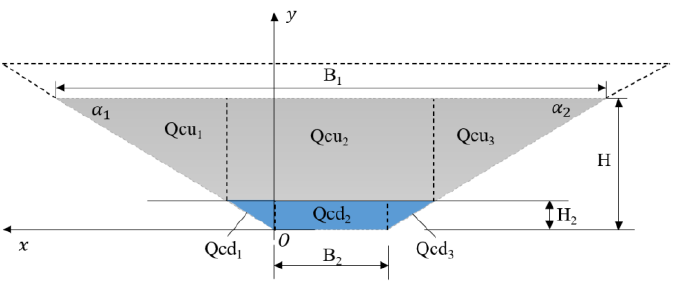
Figure 14. The longitudinal section of the core.